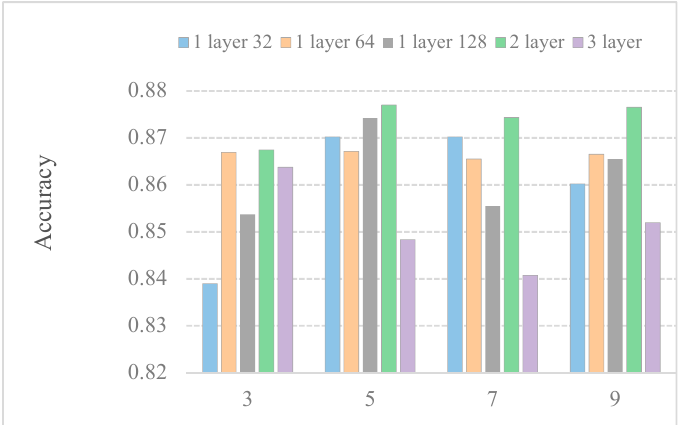
Figure 3. Performance comparison of DeepPred-SubMito with different numbers of CNN structures and kernel sizes in the SubMitoPred dataset.